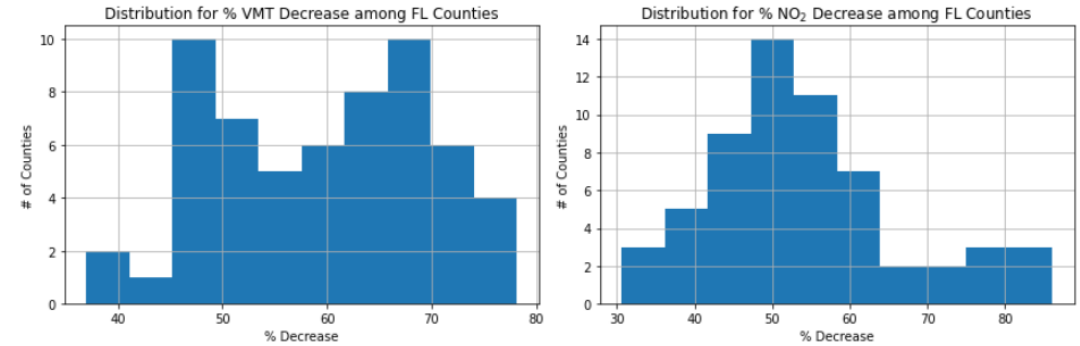
Figure 5. Distribution of % decrease on VMT and NO 2 concentrations among Florida counties.